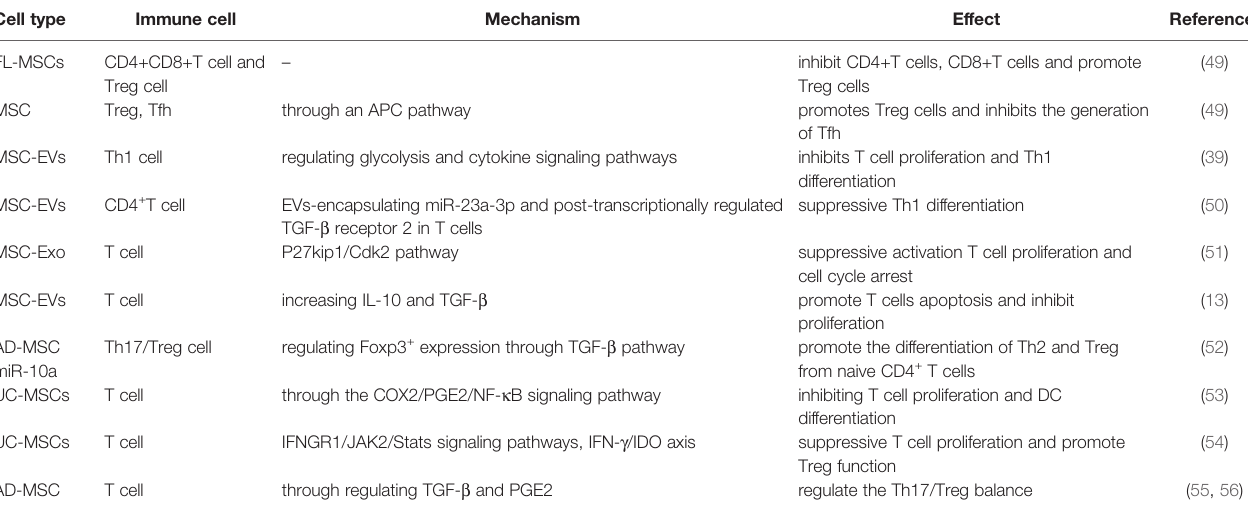
TABLE 1 | Mechanism of action with MSCs and EVs on T